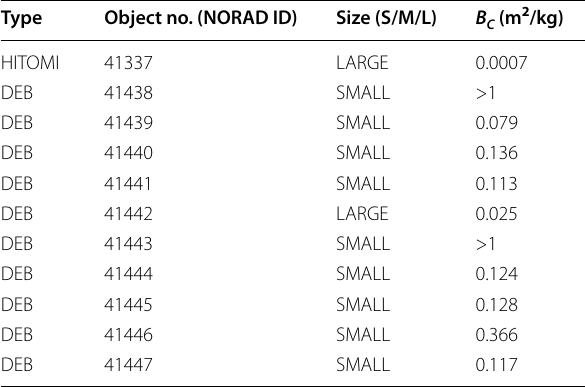
Table 4 Ballistic coefficient of catalogued Hitomi